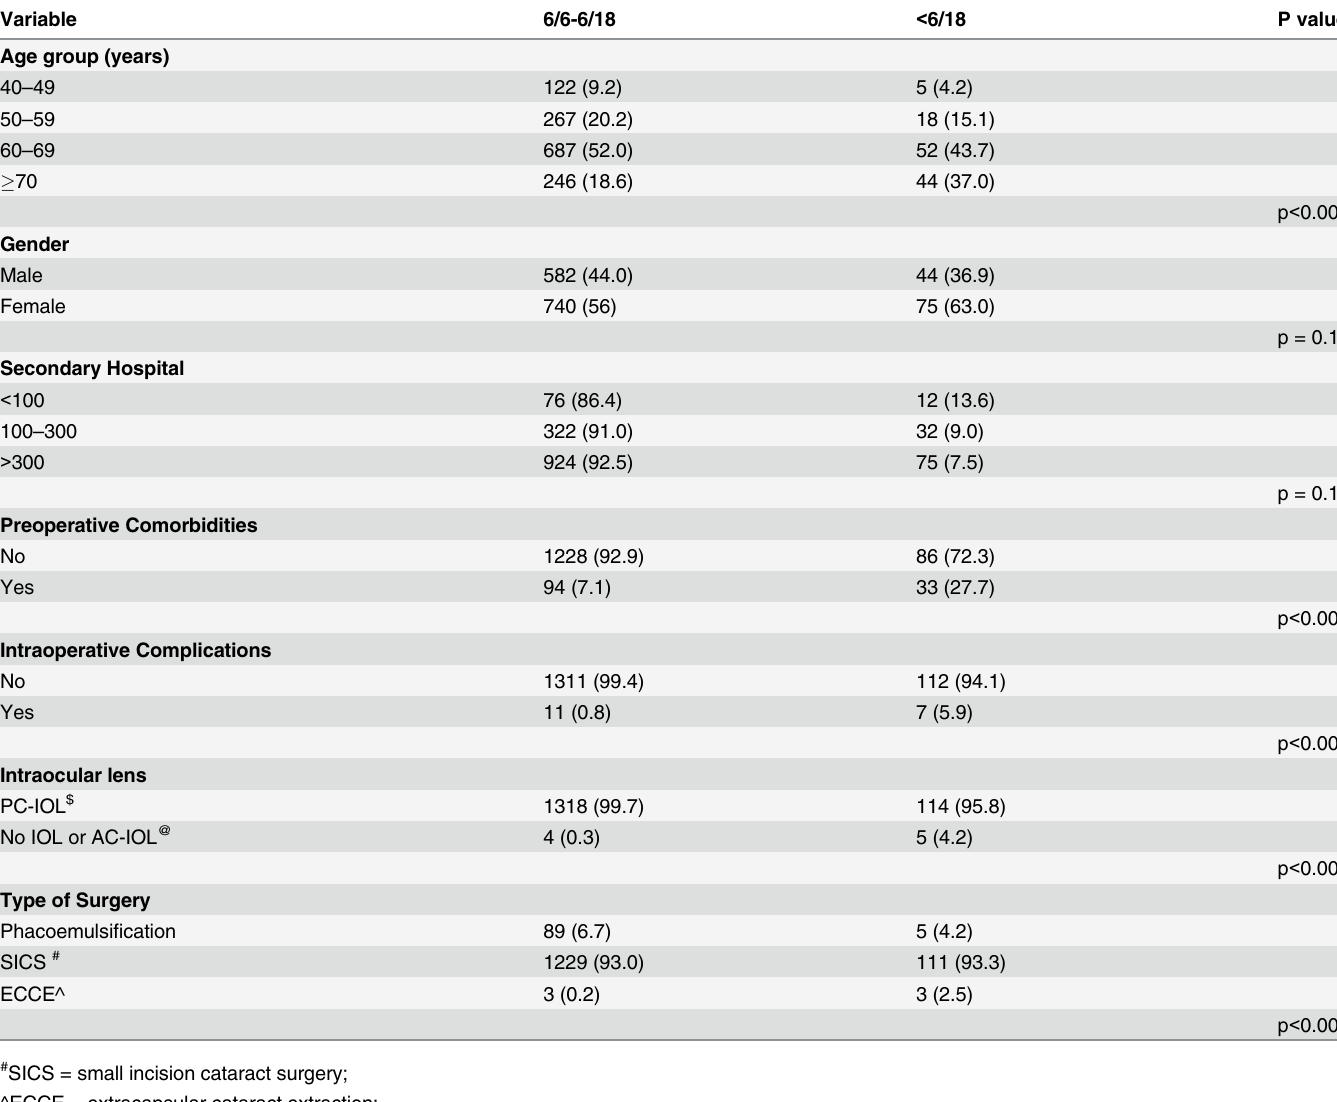
Table 5. Demographic and ocular characteristics of those with good outcome (BCVA 6/6-6/18) versus poor outcome (BCVA <